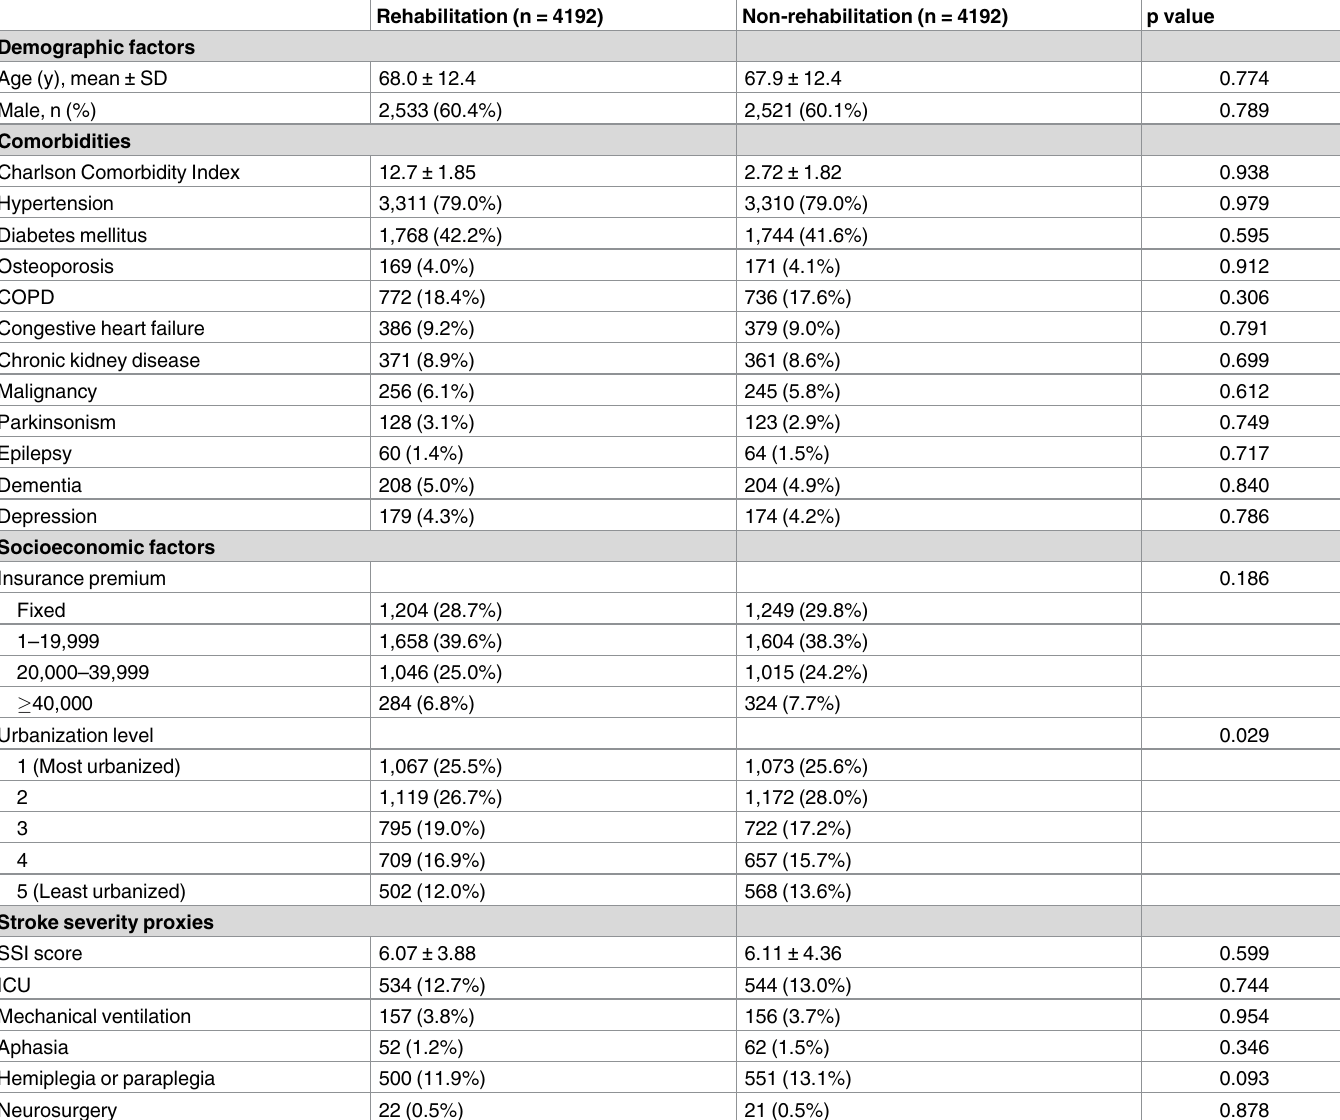
Table 1. Baseline characteristics and comorbidity of patients with and without post-stroke rehabilitation after propensity score